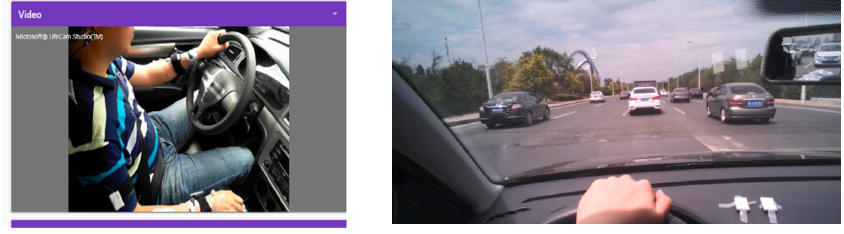
Figure 2. Experiment process record.